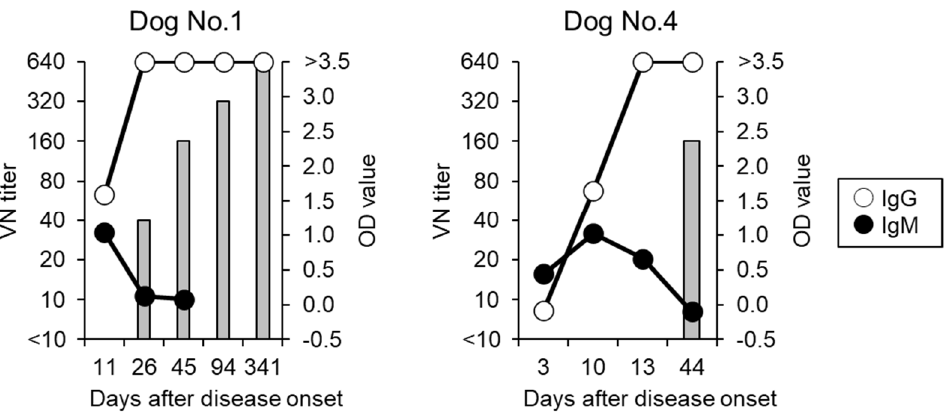
Figure 2. Changes in antibody titers of dogs with SFTS during observation. Lines indicate the OD values of the ELISA. Open and closed circles show IgG and IgM antibodies, respectively. Gray bars show VN titer by FRNT 50 .